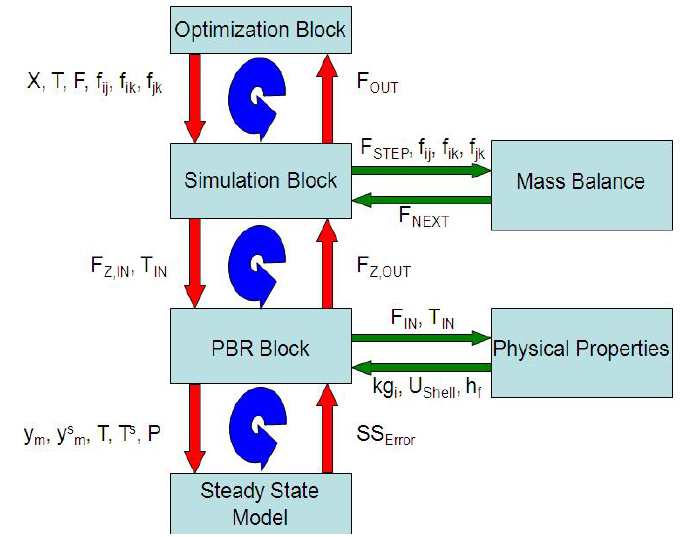
Figure 4. Proposed algorithm for superstructure